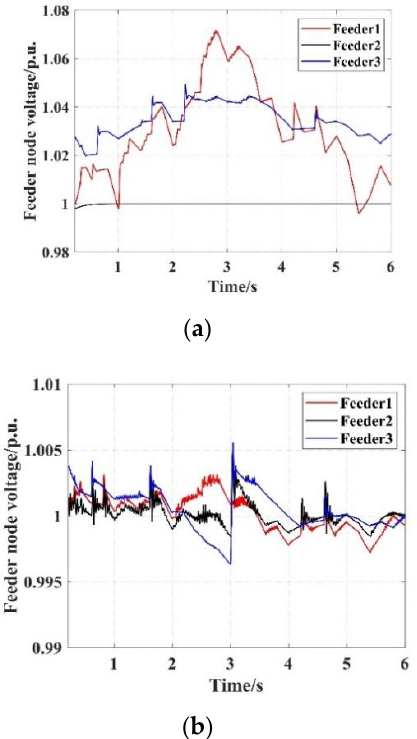
Table 2. Standard deviation of the feeder node voltage.